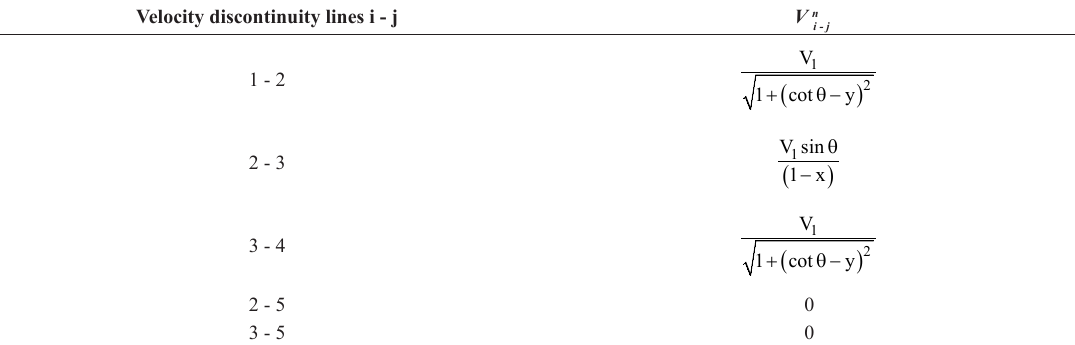
Table 2. The lines of discontinuity and sliding velocities for ECAE 2θ -die with 2θ>0° and 2θ<180° ( x=h/a and y=H/a ) in Figures 3-7. Velocity discontinuity lines i - j